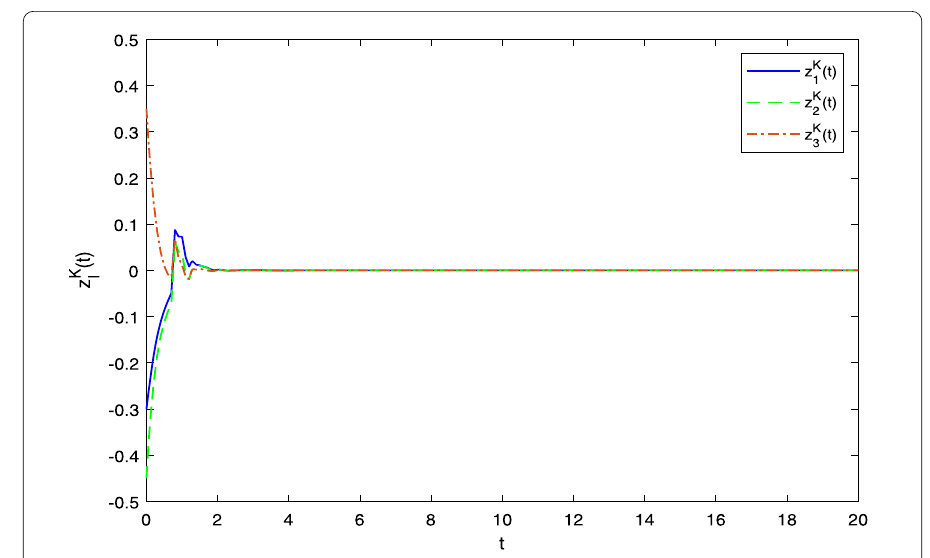
Figure 8 State trajectories of variables z K